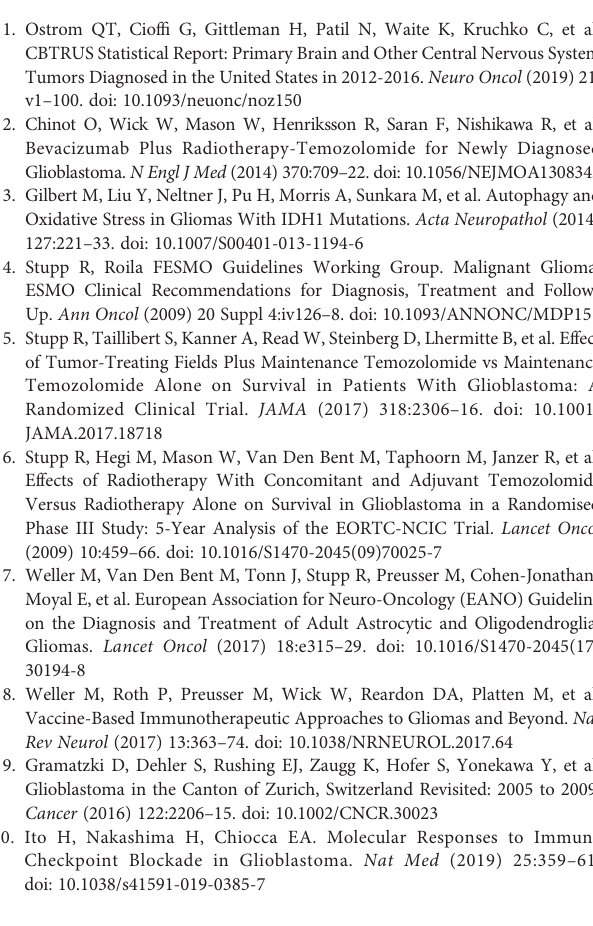
Supplementary Table 1 | Expression in healthy and cancers tissues of surface proteins over-expressed or exclusive to GBM cell lines according to Human Protein Atlas. Supplementary Table 2 | Drug candidates targeting genes speci fi c to glioma and existing therapeutic clinical trials in glioma patients. Supplementary Data Sheet 1 | Raw data before the application of any fi lters. Supplementary Data Sheet 2 | Proteins list for the clusters of the heatmap Figure 1 . Supplementary Data Sheet 3 | p-value of proteins presented on the heatmap. Supplementary Data Sheet 4 | Exclusive proteins list for each cell line. Supplementary Figure 1 | Global pathways analyses for clusters 1, 2, 3 & 4. Supplementary Figure 2 | Overall survival studies and HIS results for LGALS3BP and